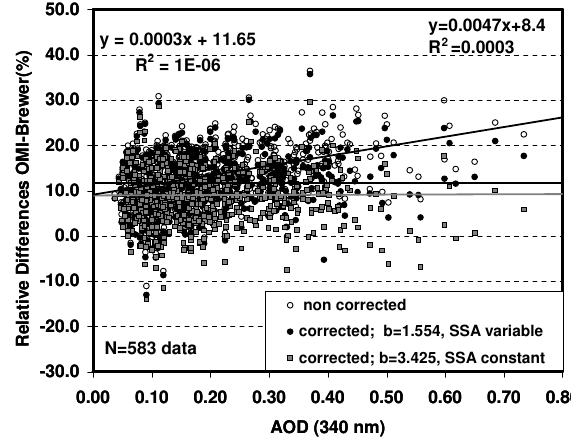
Fig. 11. Relative difference between OMI for UVER data as func- tion of aerosol optical depth without correction when the two cor- rections are applied (a) for the first correction approach with SSA constant; (b) for the second correction approach with SSA variable. The number of data ( N ) is specified inside the